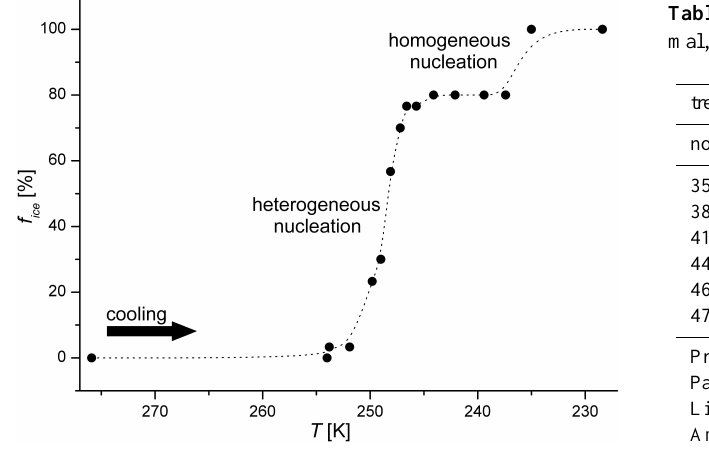
Fig. 2. The curve shows a typical nucleation curve (temperature vs. number fraction of frozen droplets f ice [%]) for an oil emulsion with washing water of hazel pollen. Some droplets nucleate at about 237K, meaning that they do not contain IN. For the determination of the median freezing point only the heterogeneous nucleation step is used. The fraction that nucleates heterogeneously in the washing water experiments is given for each species in Table 1.